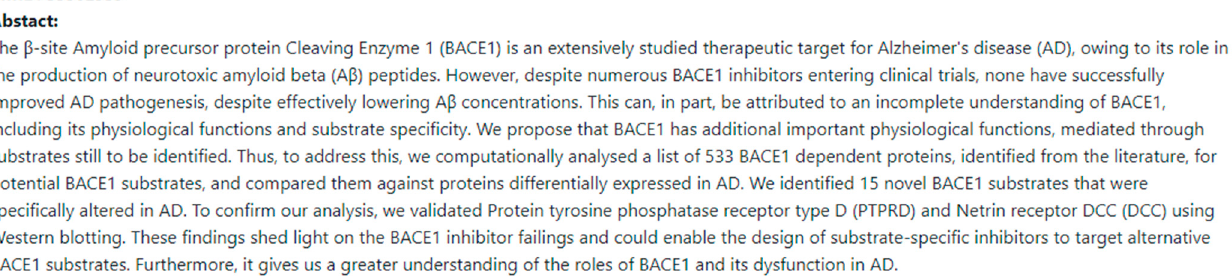
Figure 8. Abstract result screen on web page after PMID input.